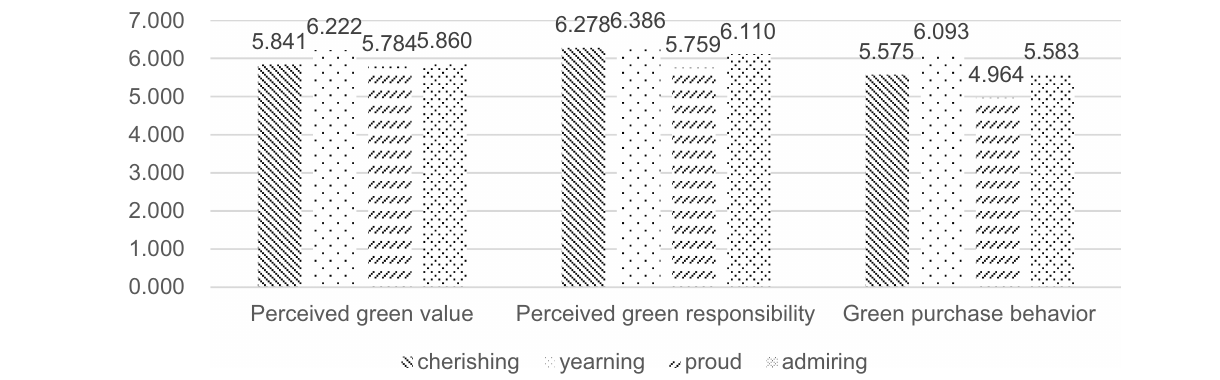
FIGURE 4 | The mean comparison of different positive